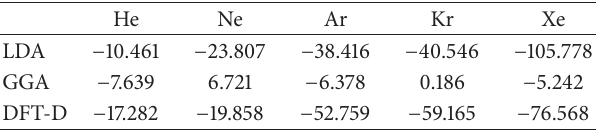
Table 4: Adsorption energies of rare gas atoms on silver aluminosil- icate